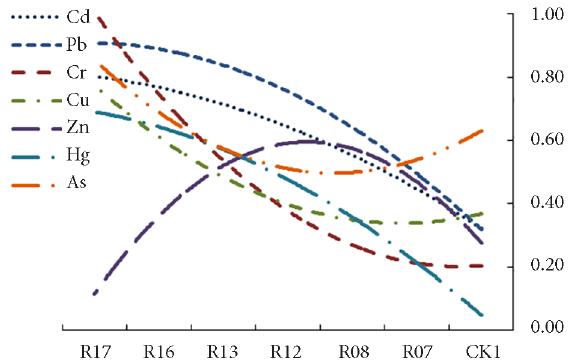
Figure 1. Changes of the potentially toxic element concentrations with the reclamation